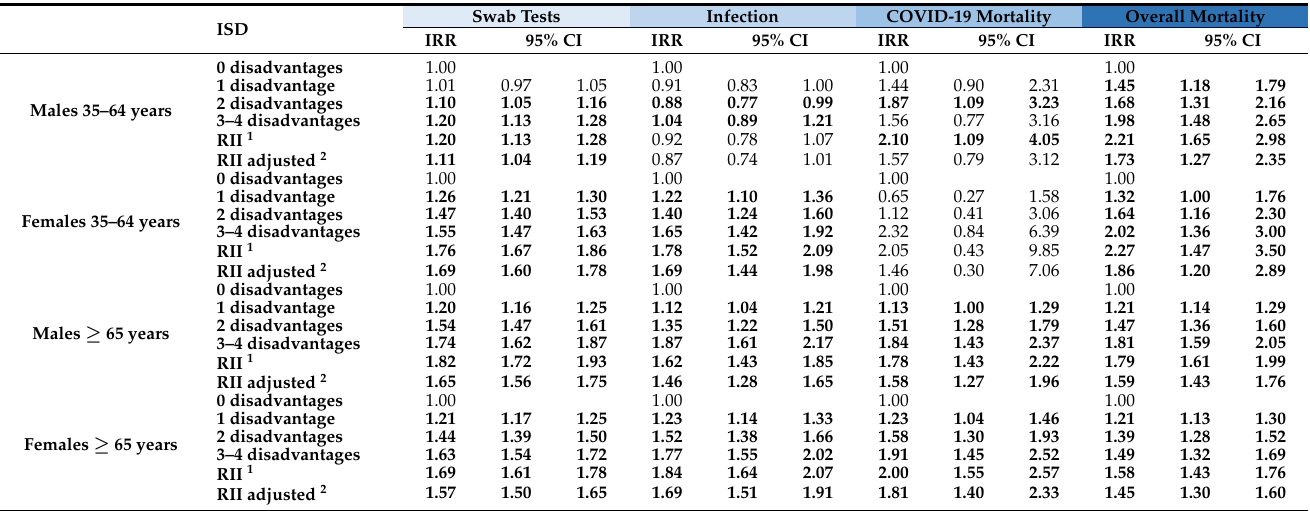
Table 2. Access to swabs, SARS-CoV-2 confirmed infection, and for COVID-19 and all-causes mortality incidence rate ratios (RR) and Relative Index of Inequality (RII) by index of socioeconomic disadvantage (ISD), gender and age